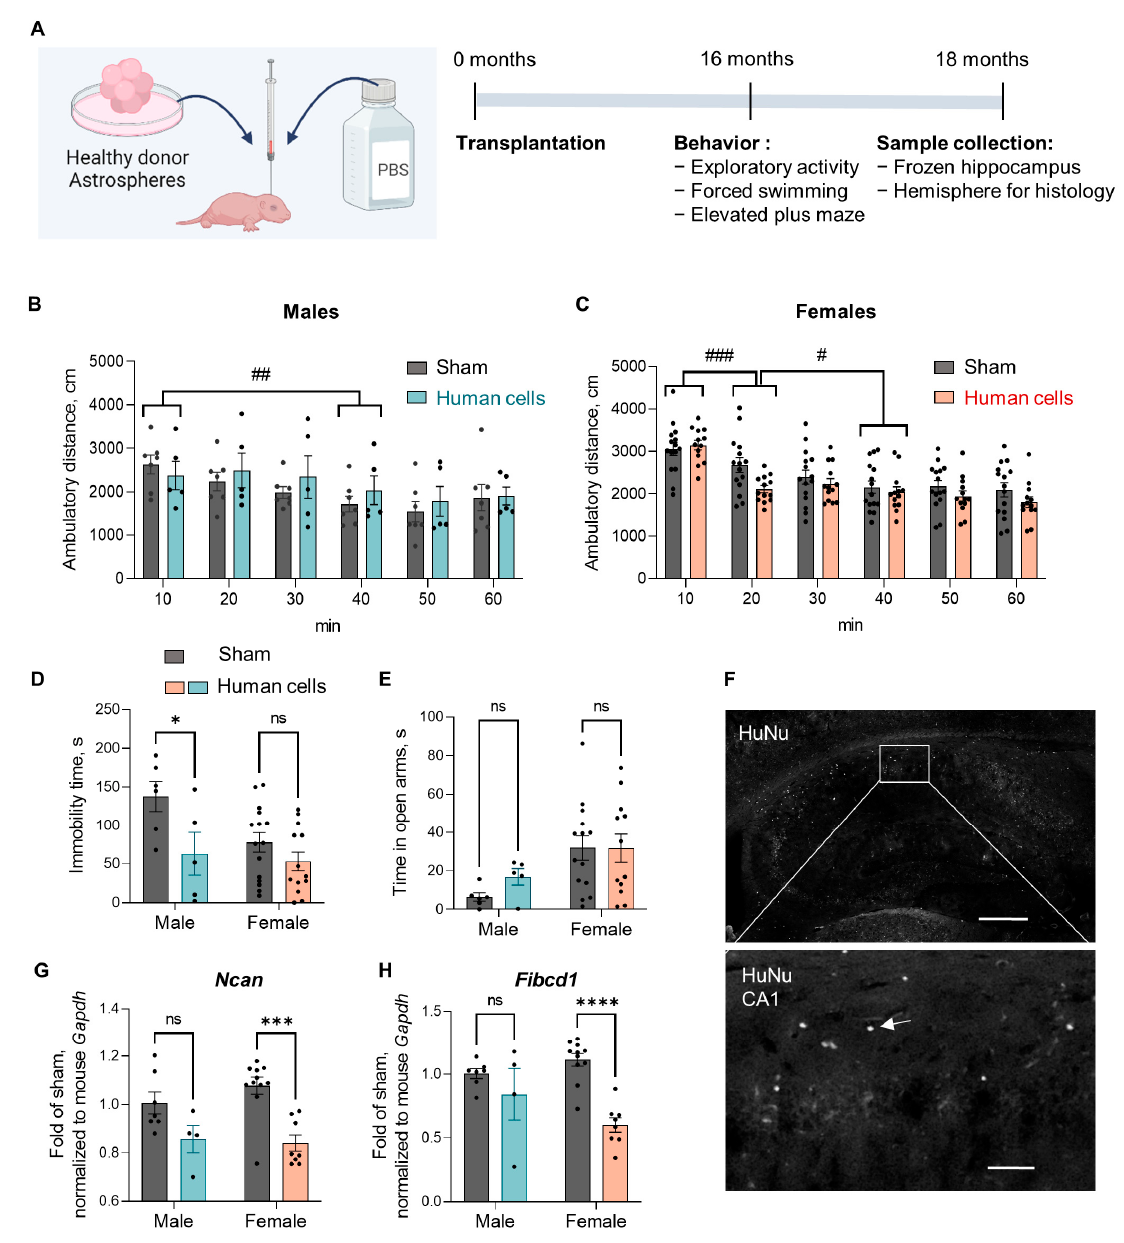
Figure 7. Human glia transplantation decreased immobility in the forced swim test in 16-month-old mice as compared to sham-operated controls. ( A ) A schematic representation of the experimental setup, created with BioRender.com (accessed on 15 December 2022); PBS, phosphate-buffered saline. ( B , C ) Total distance (cm) traveled by male ( B ) or female mice ( C ) in an open arena shown in 10-min blocks. ( D ) Immobility (floating) time (s) recorded during the last 4 min of a 6-min forced swim test. ( E ) Total time (s) spent in the open arms of the elevated plus maze. ( F ) A representative image of HuNu staining in the hippocampus, scale bar 400 µ m. HuNu-labeled cells in the CA1 area of the hippocampus are also shown at larger magnification, scale bar 50 µ m; arrow, HuNu-positive cell. ( G , H ) The relative mRNA expression level of mouse Ncan and Fibcd1 shown as fold of mouse Gapdh in the hippocampus. Grey bars indicate sham-operated mice, blue bars indicate human glia- transplanted males, and salmon human glia-transplanted females. The data in the graphs are shown as mean ± SEM; n = 4–15 per group; * p < 0.05, *** p < 0.001, **** p < 0.0001 as compared to sham; # p < 0.05, ## p < 0.01, ### p <